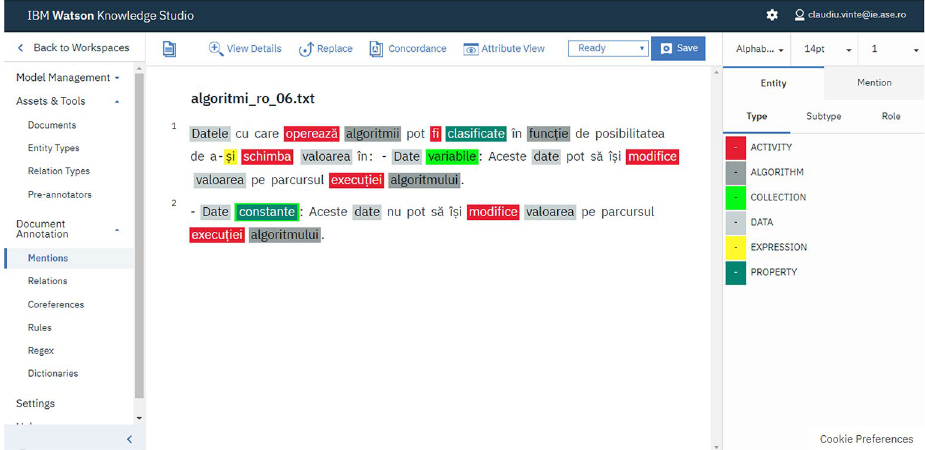
Figure 4. The results of pre-annotation process applied on document used for training